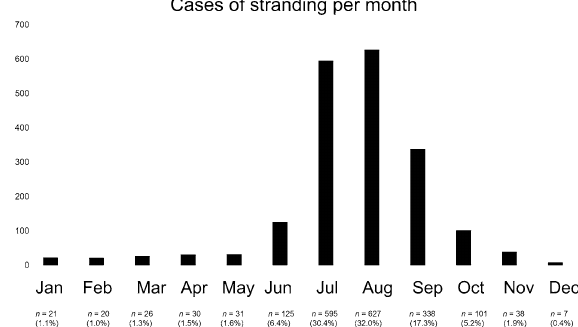
Figure 3. Most cases of being stranded were in the summer months of July and August.